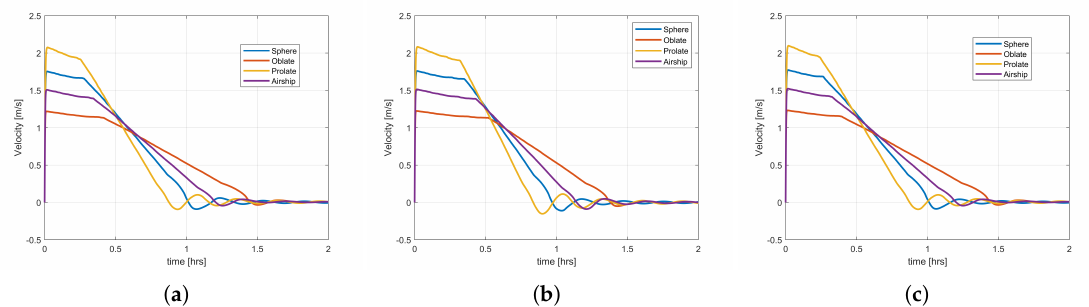
Figure 18. Ascent speed variation of different balloon types at a particular fineness ratios ( a ) ZP ( b ) SP ( c ) OZP balloons. The fineness ratio used for comparison is 3 for oblate, 0.4 for airship and 0.6 for prolate